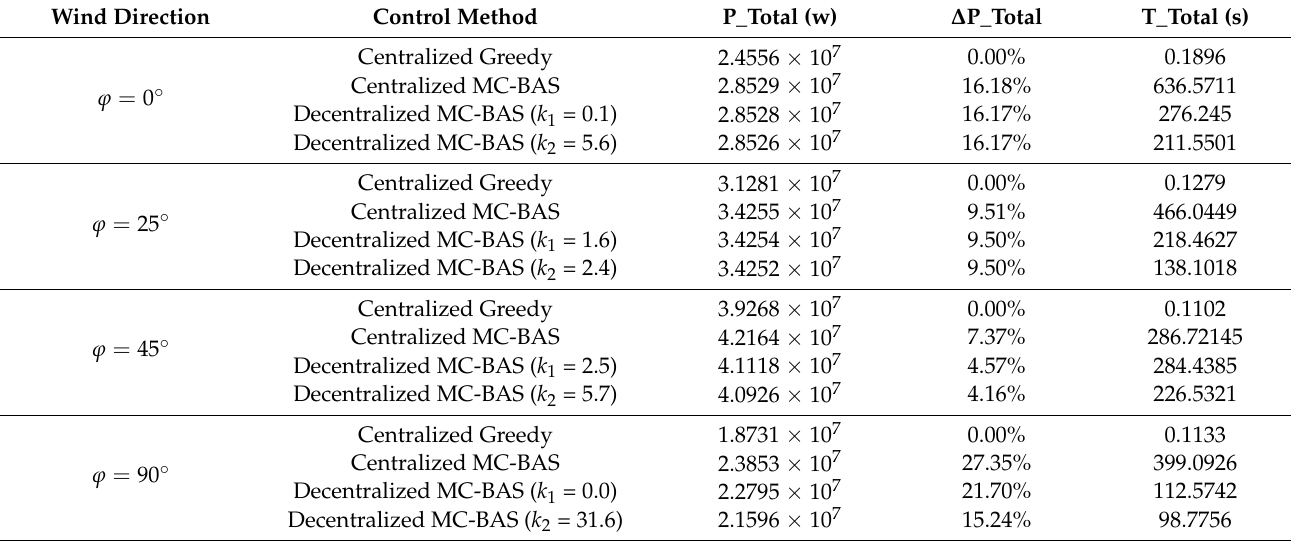
Table 4. Comparison of power output and calculating time on OWF using centralized and decentralized algorithms on 5 × 5 matrix wind